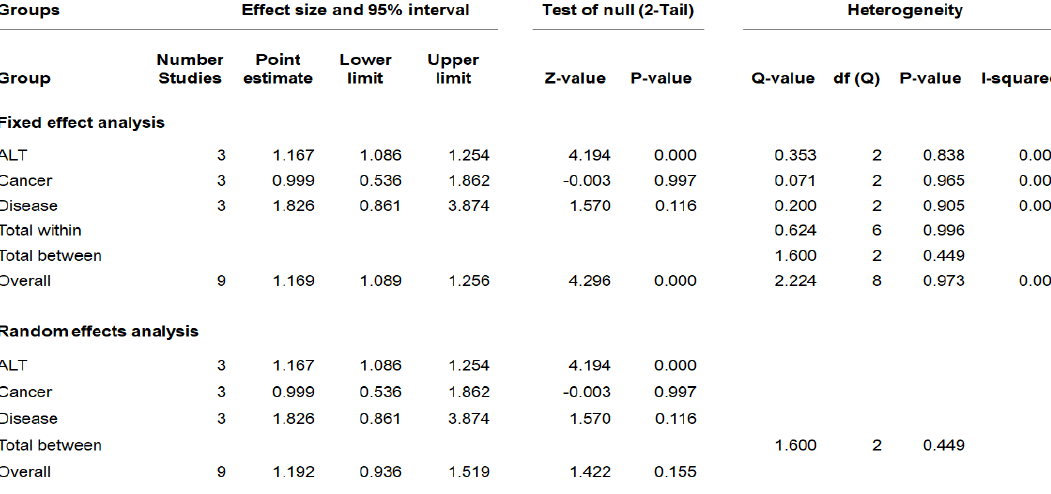
Figure 3. Effect size of PFOA exposure according to variables related to hepatic